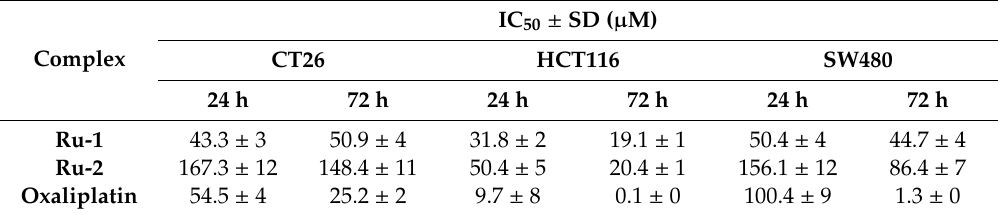
Table 1. IC 50 values of tested compounds obtained by MTT assay after 24 and 72 h exposure. Complex